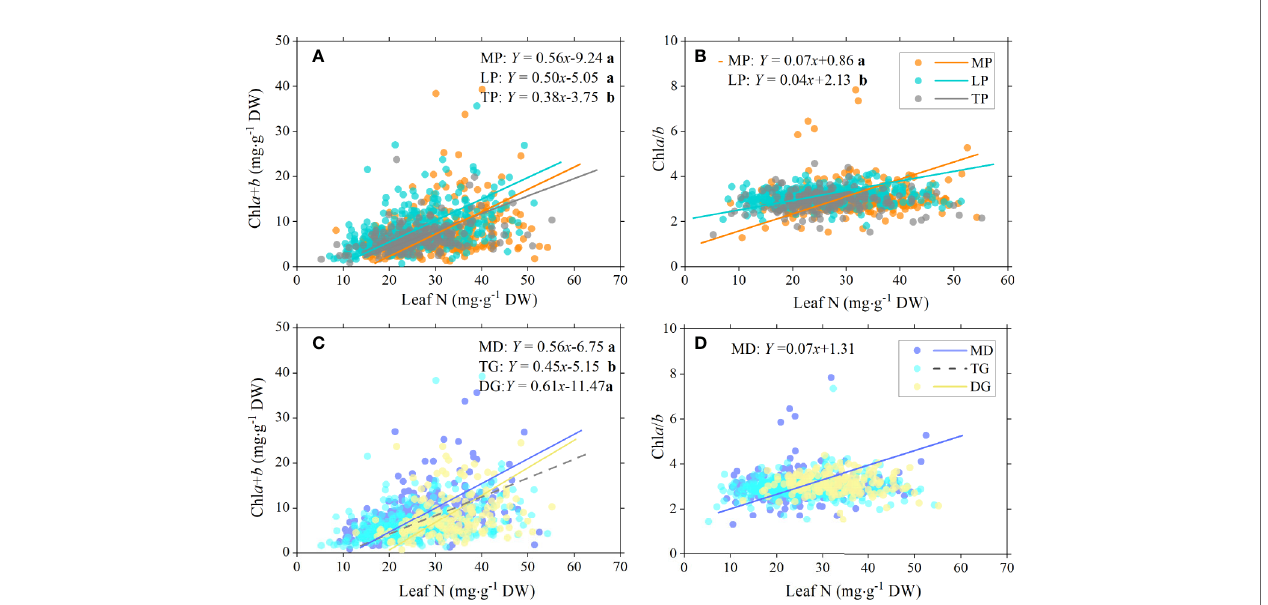
FIGURE 6 | Standardized major axis (SMA) regression of chlorophyll total concentration (chl a + b ) and ratio (chl a / b ) to leaf N for different regions and grassland types. Relationships between total chlorophyll concentration and leaf nitrogen (A) , and between chlorophyll ratio and leaf nitrogen (B) for three plateau regions are showed , respectively. Corresponding relationships between chlorophyll and leaf nitrogen in three grassland types are showed in (C, D) . Lines denote signi fi cant linear relationships ( p < 0.05). Fitting functions are given only for signi fi cant linear relationships. Different lowercase letters behind functions indicate signi fi cant difference between SMA slopes ( p < 0.05). MP, Mongolia Plateau; LP, Loess Plateau; TP, Tibet Plateau; MD, meadow; TG, typical grassland; DG, desert